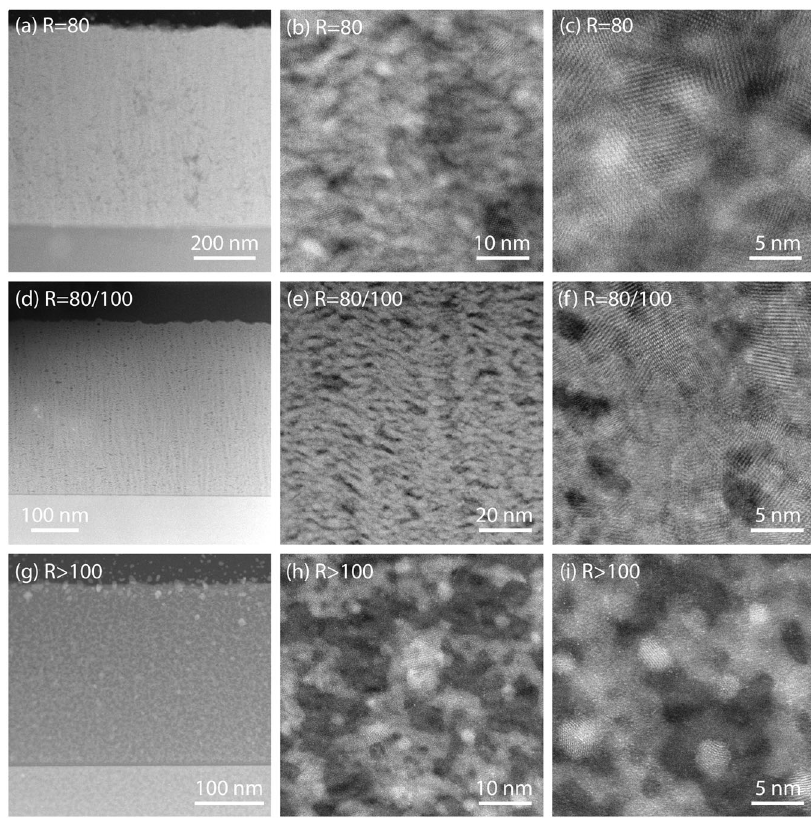
Fig. 3 High-angle annular dark- fi eld images of cross-sectional scanning transmission electron microscopy. Three plasma-enhanced chemical vapor- deposited nc -Si fi lms with R = 80 in a – c , R = 80/100 in d – f , and R > 100 in g – i are shown. The white particles extending into the glue line above the fi lm in g are redeposition artifacts from the ion milling preparation. Scale bars are given at the bottom of each